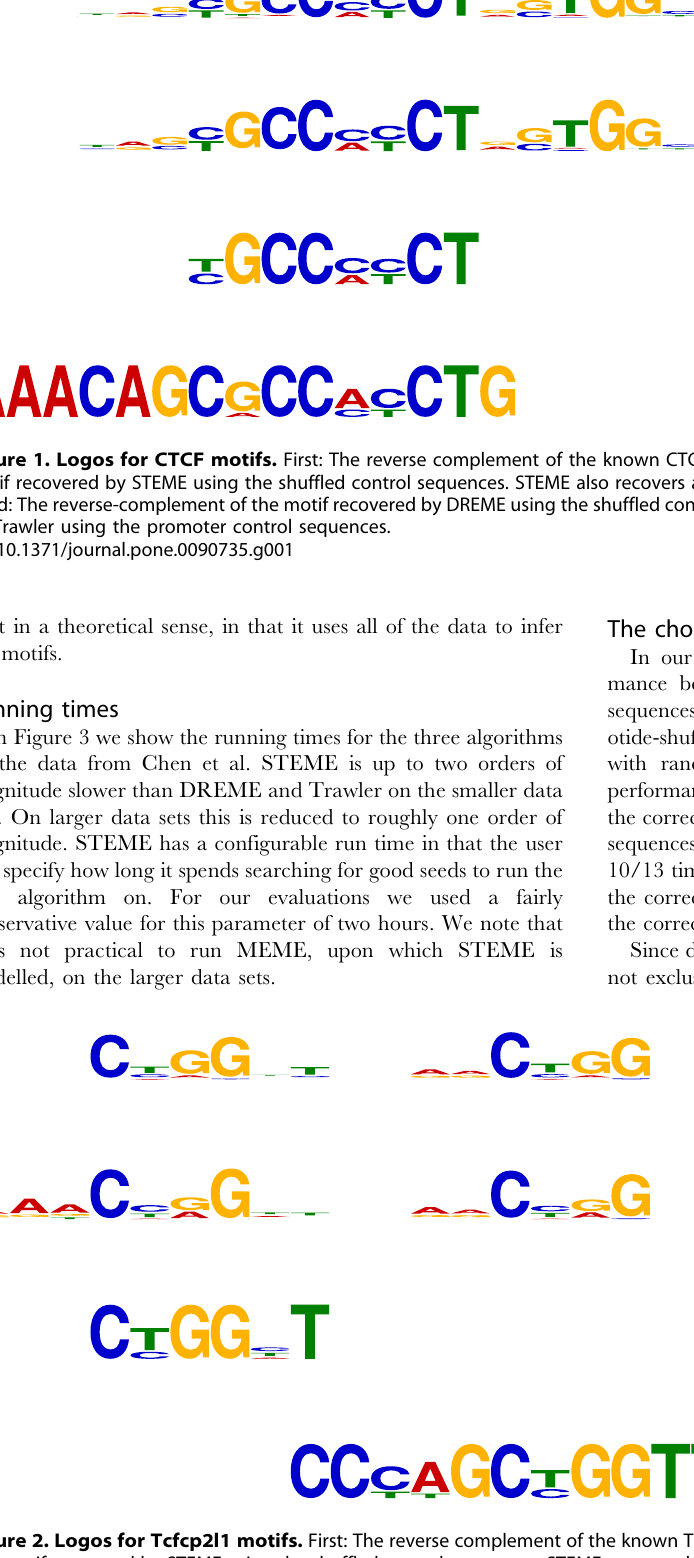
Figure 2. Logos for Tcfcp2l1 motifs. First: The reverse complement of the known Tcfcp2l1 motif from the JASPAR database (MA0145.1). Second: The motif recovered by STEME using the shuffled control sequences. STEME recovered a near identical motif using the promoter control sequences. Third: The reverse-complement of the motif recovered by DREME using the shuffled control sequences. Fourth: The Tcfcp2l1 motif recovered by Trawler when using the promoter control sequences.